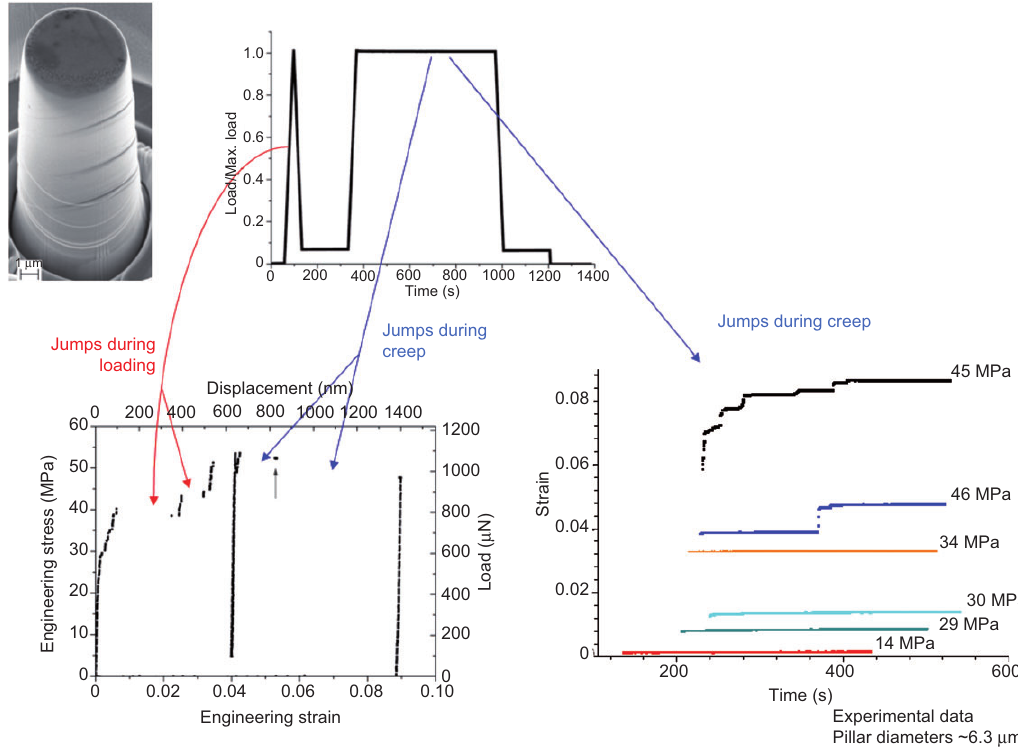
Figure 3 Jumpy deformation in aluminum micropillars during load ramp and creep. Data from ref. [18]